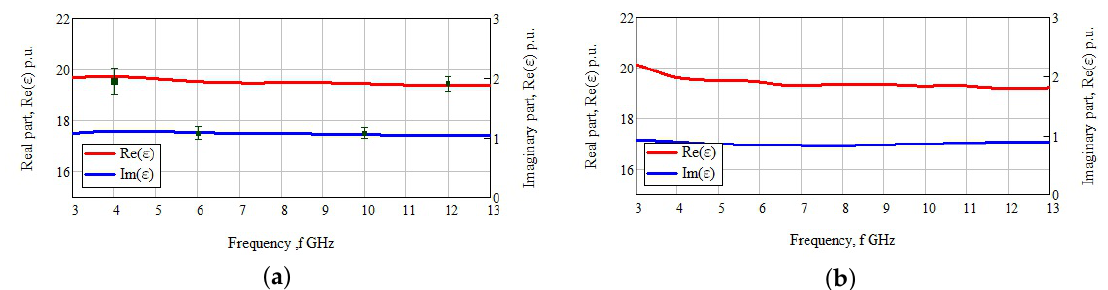
Figure 13. The values of the real and imaginary parts of the dielectric permittivity measured using a developed laboratory model ( a ) and an Agilent setup ( b